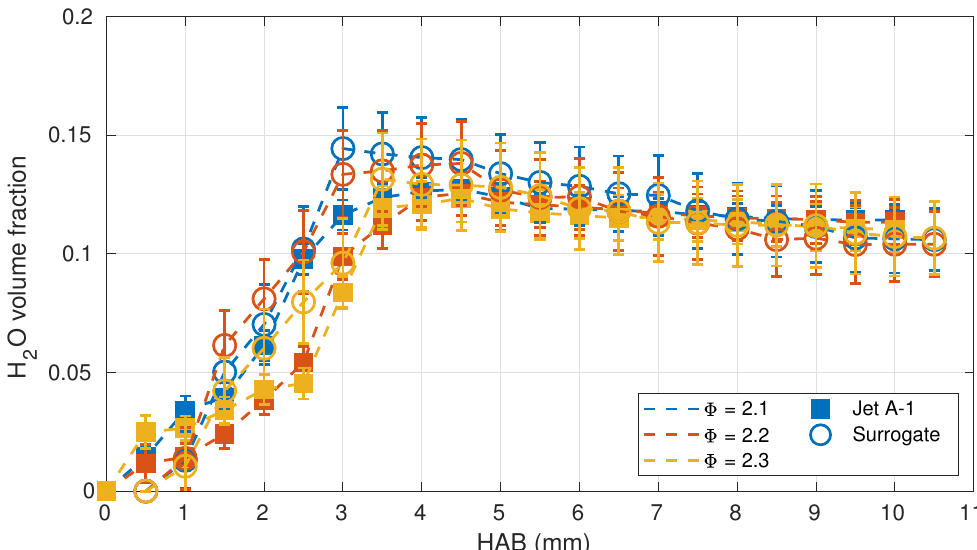
Figure 2. Profiles of water concentration measured with TDLAS at 6 cm/s inlet velocity.